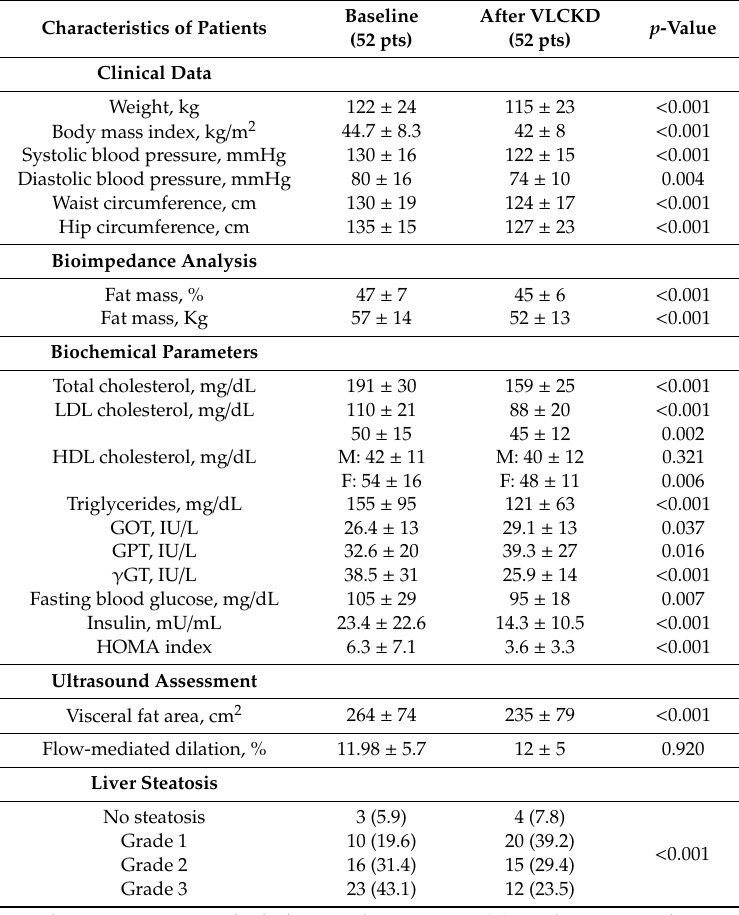
Table 1. Anthropometric, clinical, biochemical, and ultrasonographic characteristics at baseline and after VLCKD. Continuous values are expressed as mean ± standard deviation; distributions are expressed as numbers (%).